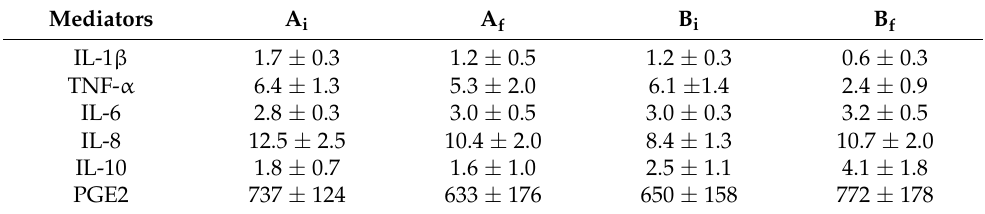
Table 5. Mean concentration and standard deviation of measured inflammatory mediators for the groups A and B at the beginning (i) and the end (f) of the